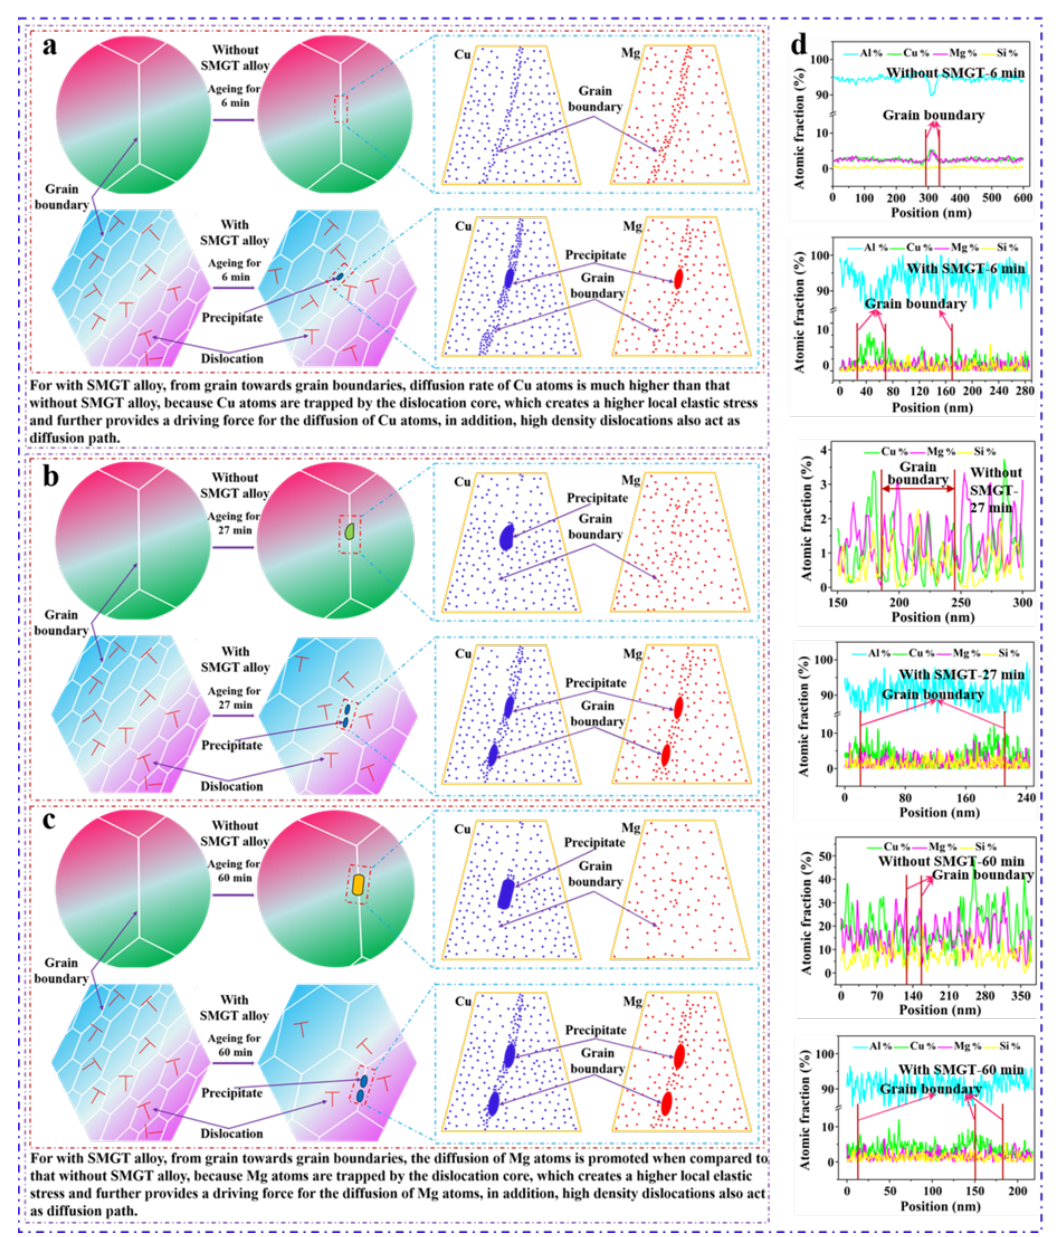
Figure 11. Schematic illustration of the elements’ segregation and precipitation at the grain boundary with and without SMGT alloys under 210 ◦ C aging for ( a ) 6 min, ( b ) 27 min, and ( c ) 60 min. The corresponding STEM-EDS line scan curves are displayed in ( d